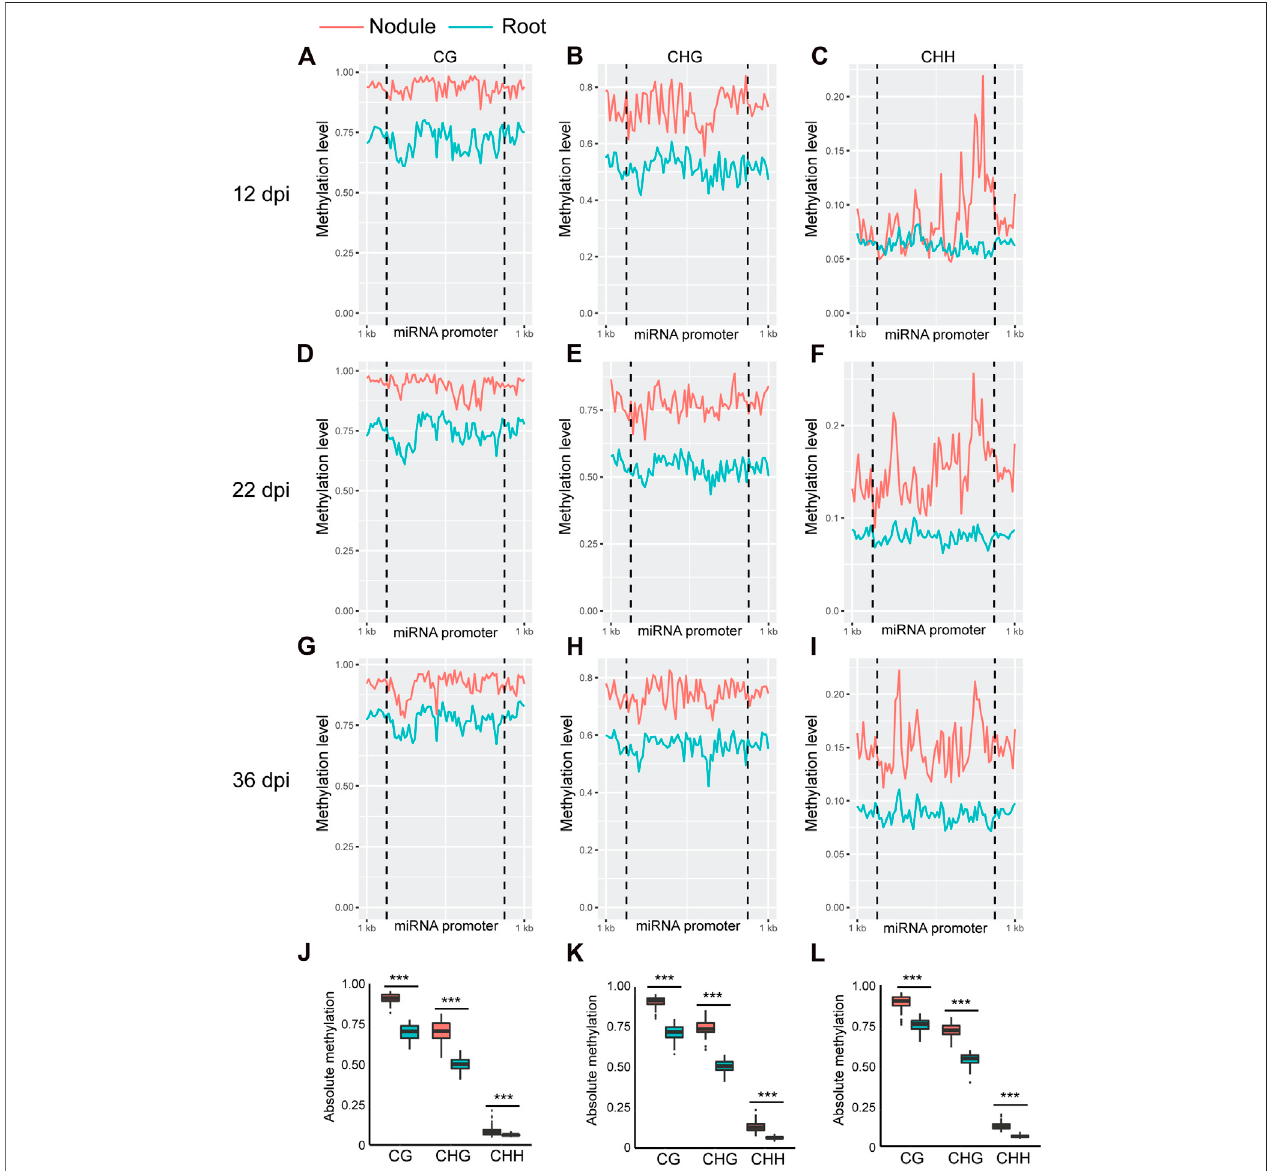
FIGURE1| AbsoluteDNAmethylationlevelsacrossmiRNAgenesinsoybeannodulesandrootsat12,22,and36dpi. (A – I) :DifferencesinglobalDNAmethylation levels between nodules and roots over miRNA genes in the CG, CHG, and CHH sequence contexts at 12 (A – C) , 22 (D – F) , and 36 – dpi (G – I) . The vertical dotted lines fl ank the prompter region, and 1 kb indicates the distance from the middle of miRNA promoter. (J – L) : Boxplots demonstrating statistically signi fi cant differences in absolute methylation levels across miRNA genes between nodules and roots in various sequence contexts at 12 (J) , 22 (K) and 36 dpi (L) . Asterisks indicate p < 0.001 for the comparison between nodules and roots as determined by t